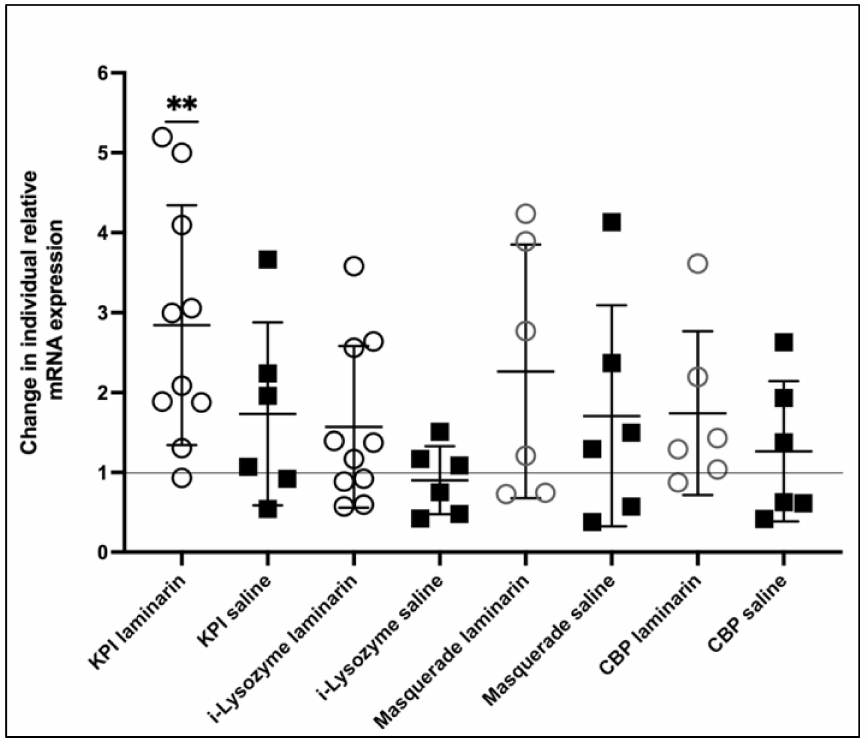
Figure 6. Changes in relative mRNA expression after saline or laminarin injection. Each dot repre- sents the change in expression in hemocytes from one individual animal, six hours after injection. Statistical analyses were performed with a One sample t- and Wilcoxon test where two asterisks (**) means a p -value < 0.005, indicating significant change in expression after injection compared to the expression before. KPI: Kazal-type protease inhibitor, CBP: putative chitin-binding